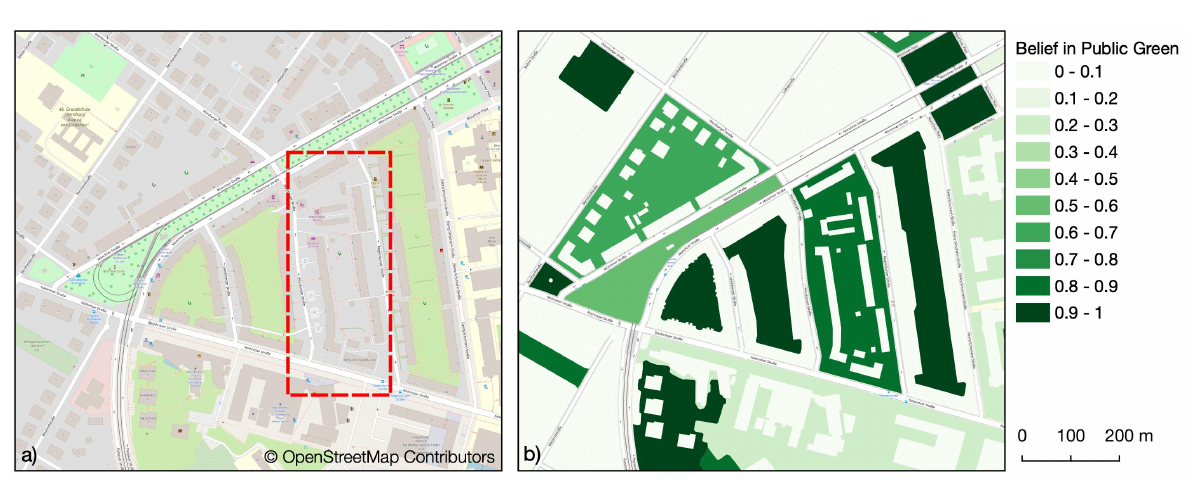
Figure 11. Example of a publicly accessible green space detected by the model: ( a ) The red rectangle marks a public green space which has not been mapped in OSM and ( b ) Belief in the presence of a public green space. The unmapped public green space shows a high level of belief, which means it was correctly detected by the model.